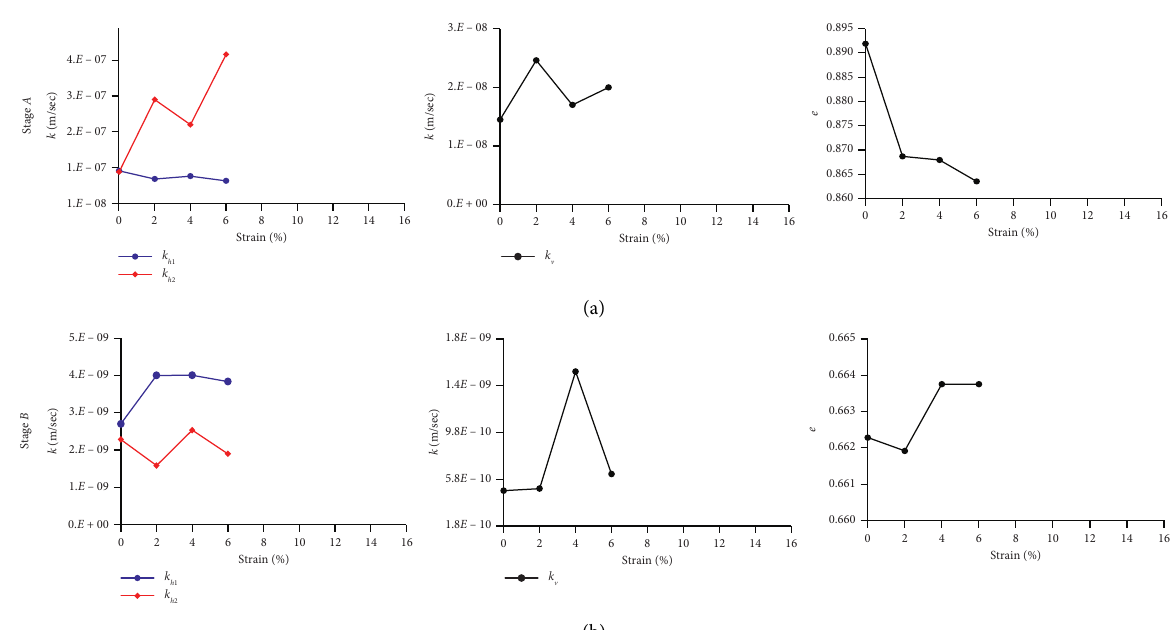
k v , and e vs. strain for each stage of sample Ι h 1 , k h 2 ,